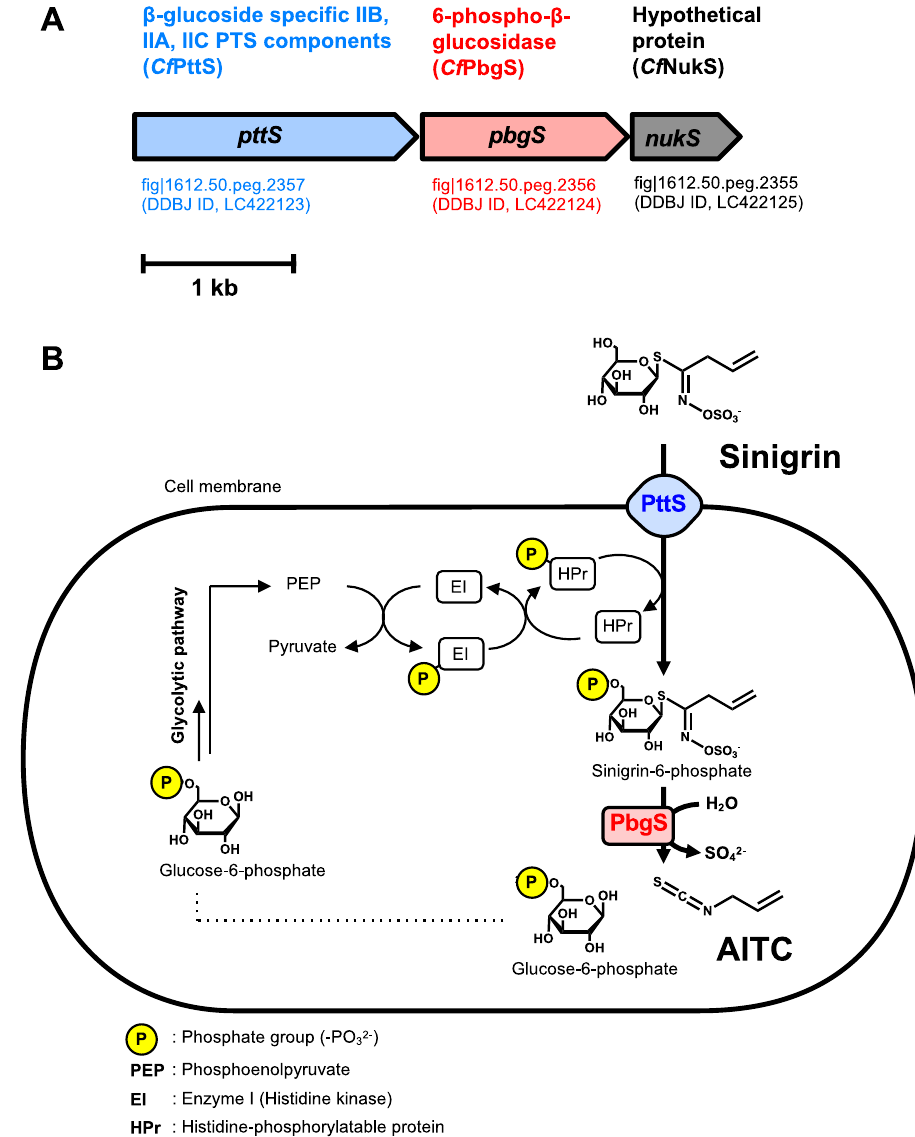
Figure 3. The gene cluster encoding the candidate proteins found in the genome of Cb. farciminis KB1089 ( A ) and the putative pathway of sinigrin degradation ( B